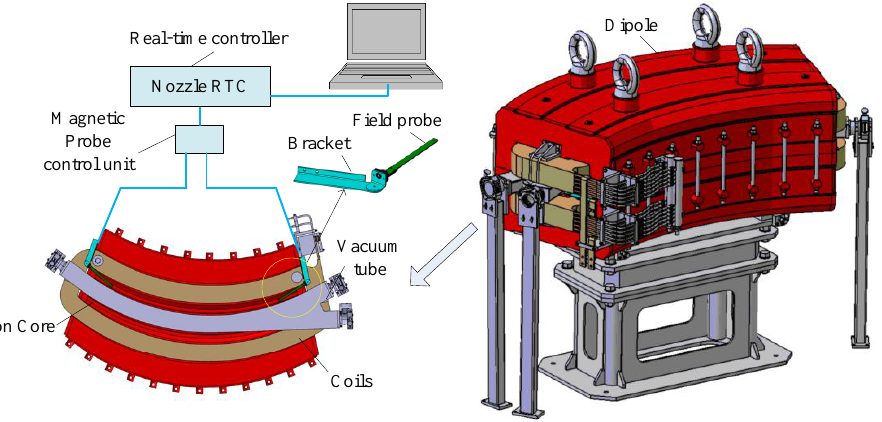
Figure 5. Schematic diagram of Hall probe and dipole magnet.